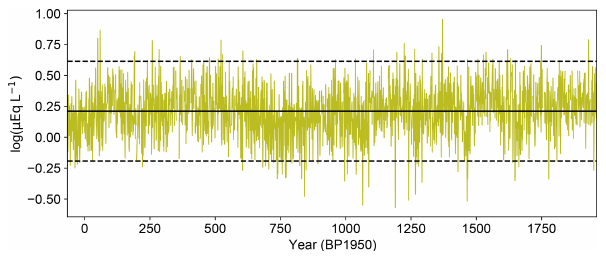
Figure 11. Time series for annually averaged magnesium. Solid black line indicates the 2000-year mean value. Dashed black line indicates 2 σ value. The lower panel indicates the number of indi- vidual samples in the year used for the average value.